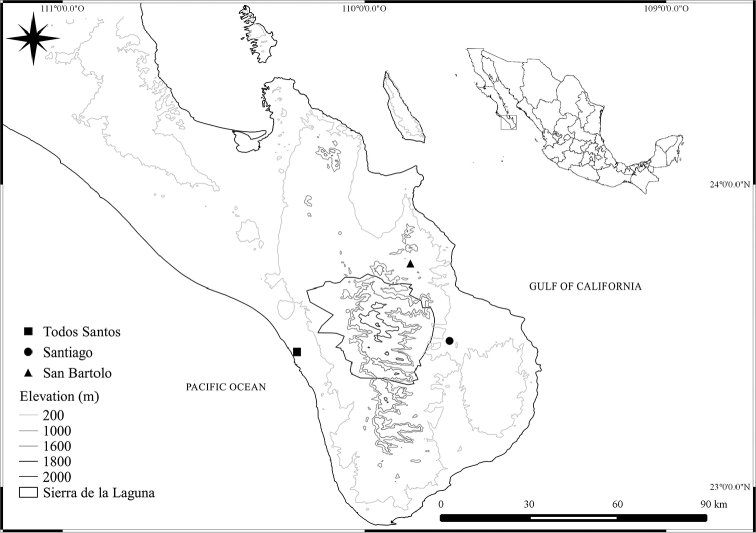
Localities in which was registered the presence of E.
viridissima in the Cape Region. Biogeographic Provinces map from CONABIO (1997).